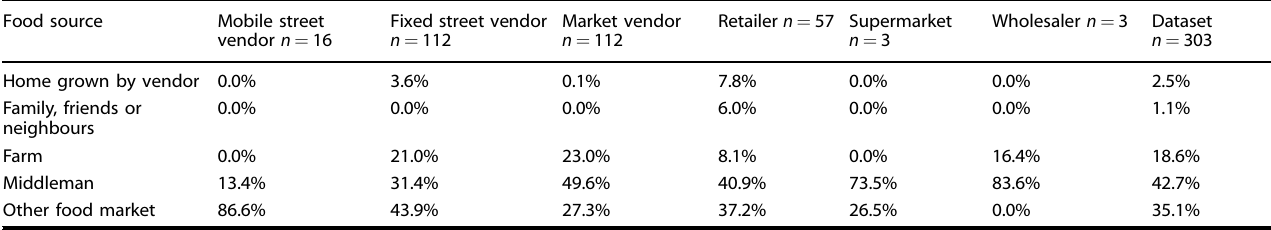
Table 2. Food sources where the surveyed food vendors ( n = 303) obtain their